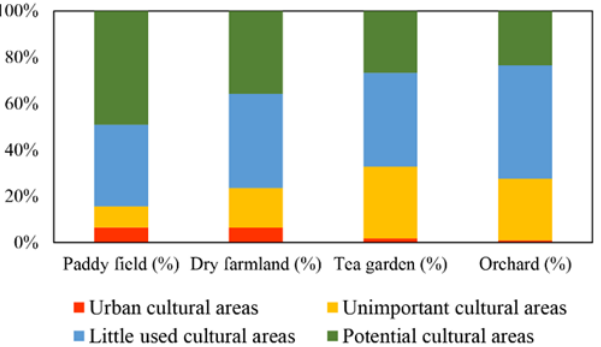
Figure 5. Distribution of different CES groups in each agricultural land use type.